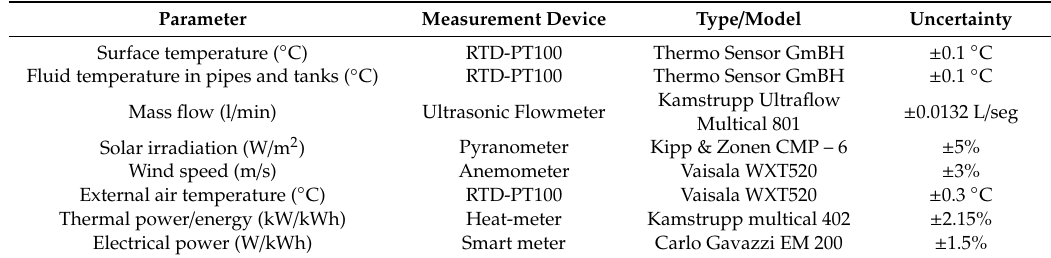
Table 2. Description of the experimental measurement